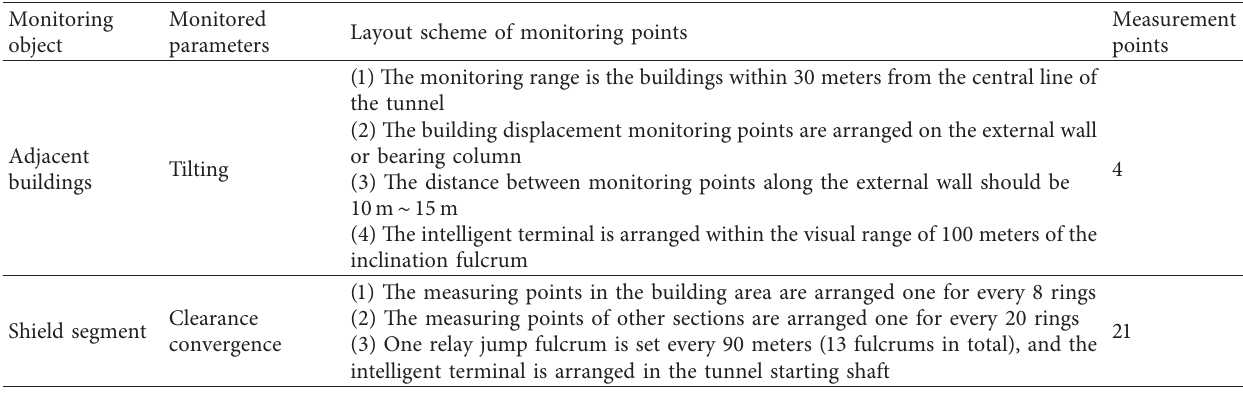
Table 2: Monitoring scheme of shield construction affected